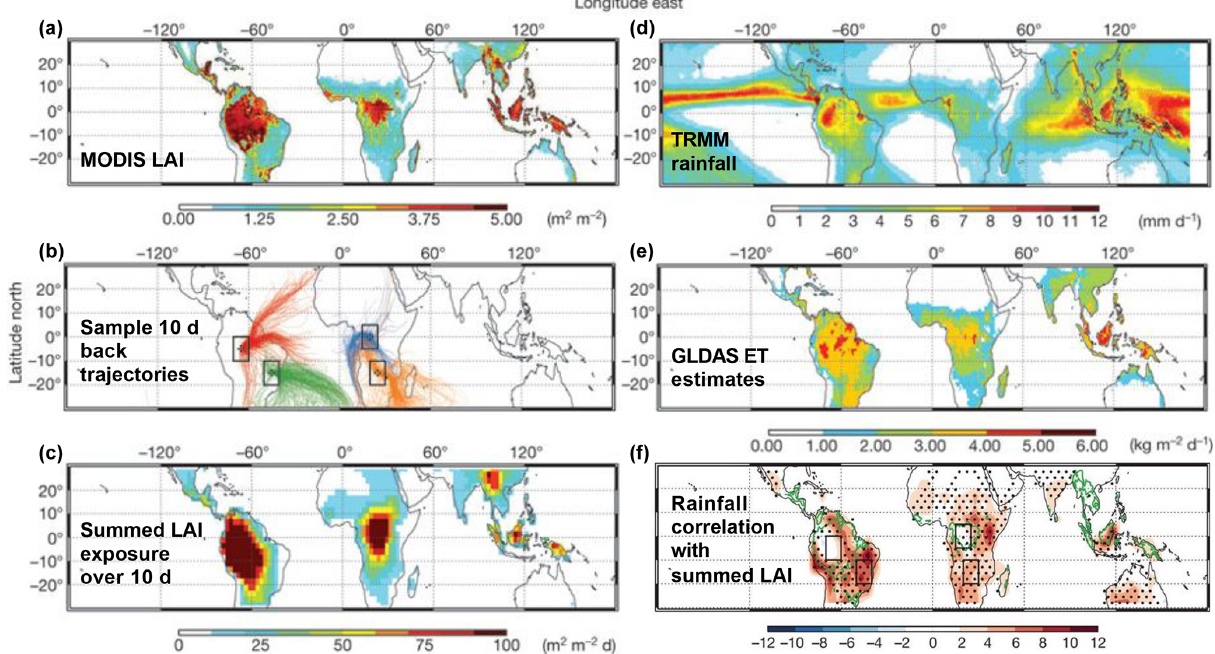
Figure 17. Ten-day back-trajectory analysis over several regions of the continental tropics along with LAI, mean Tropical Rainfall Measuring Mission (TRMM) estimated rainfall, and Global Land Data Assimilation System (GLDAS) ET